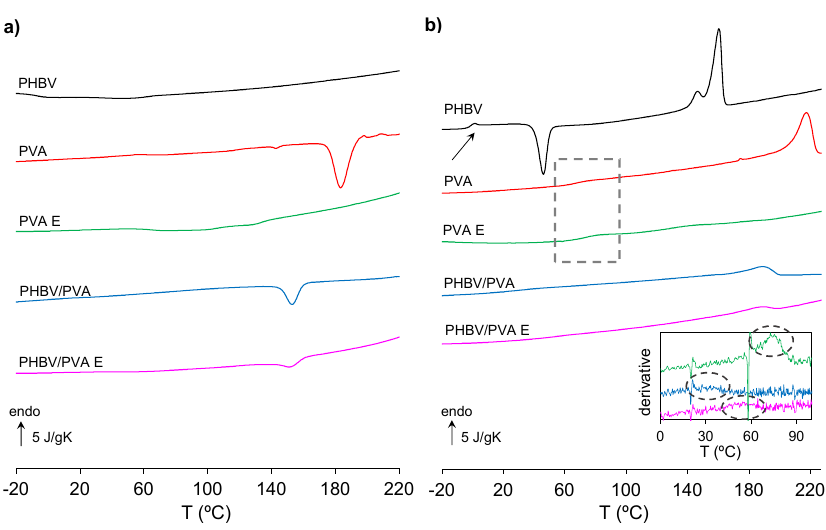
Figure 6. Differential scanning calorimetry (DSC) thermograms at a rate of 20 °C/min of neat PHBV and PVA, PHBV/PVA blend and PHBV/PVA E. ( a ) Normalized heat flow ( c p ) on cooling. ( b ) Normalized heat flow ( c p ) on heating. Arrows and rectangle mark the glass transition process. The inset shows the temperature derivative of the heat capacity from 0 to 100 °C ( dc p /dT) . The arrow and dotted area in ( b ) and the inset indicate the glass transition process.